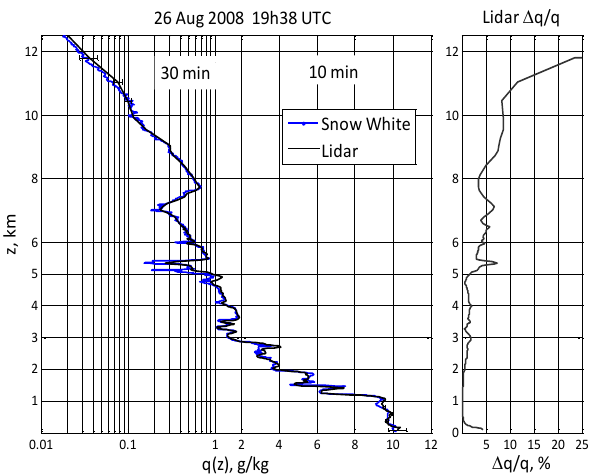
Fig. 12. Left: Vertical water vapor mixing ratio profiles mea- sured quasi-simultaneously by the lidar and an equipped-with Snow White radiosonde (chilled mirror hygrometer). The sonde was launched at 19:38UTC. Time averaging 10min below 3km and 30 min above. The vertical resolution is variable; initial 15m, above 4km – minimum 30m, above 6.5km – minimum 105m, above 9km – minimum 300m; above 11km the resolution is 900m (maximum allowed). Right: Lidar statistical error